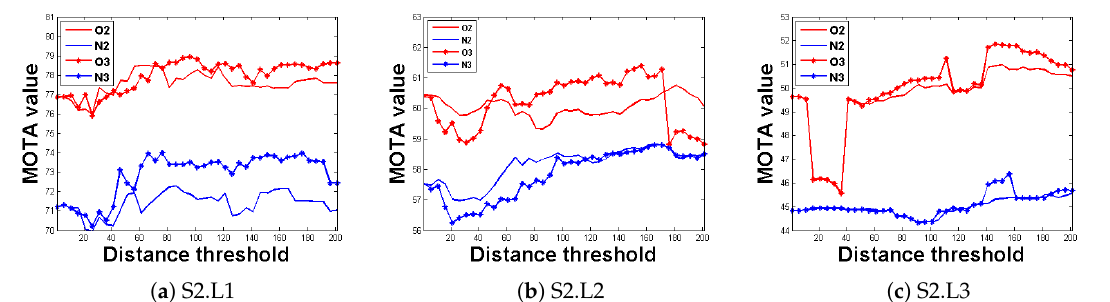
Figure 7. Evaluation results of the key point optimization. The horizontal axis represents the distance threshold, while the vertical axis represents the tracking accuracy. The solid line indicates that the experiment is conducted using data from two views, while the asterisk line indicates that the experiment is conducted using data from three views. Red represents the tracking system with key point optimization and blue indicates the tracking system without key point